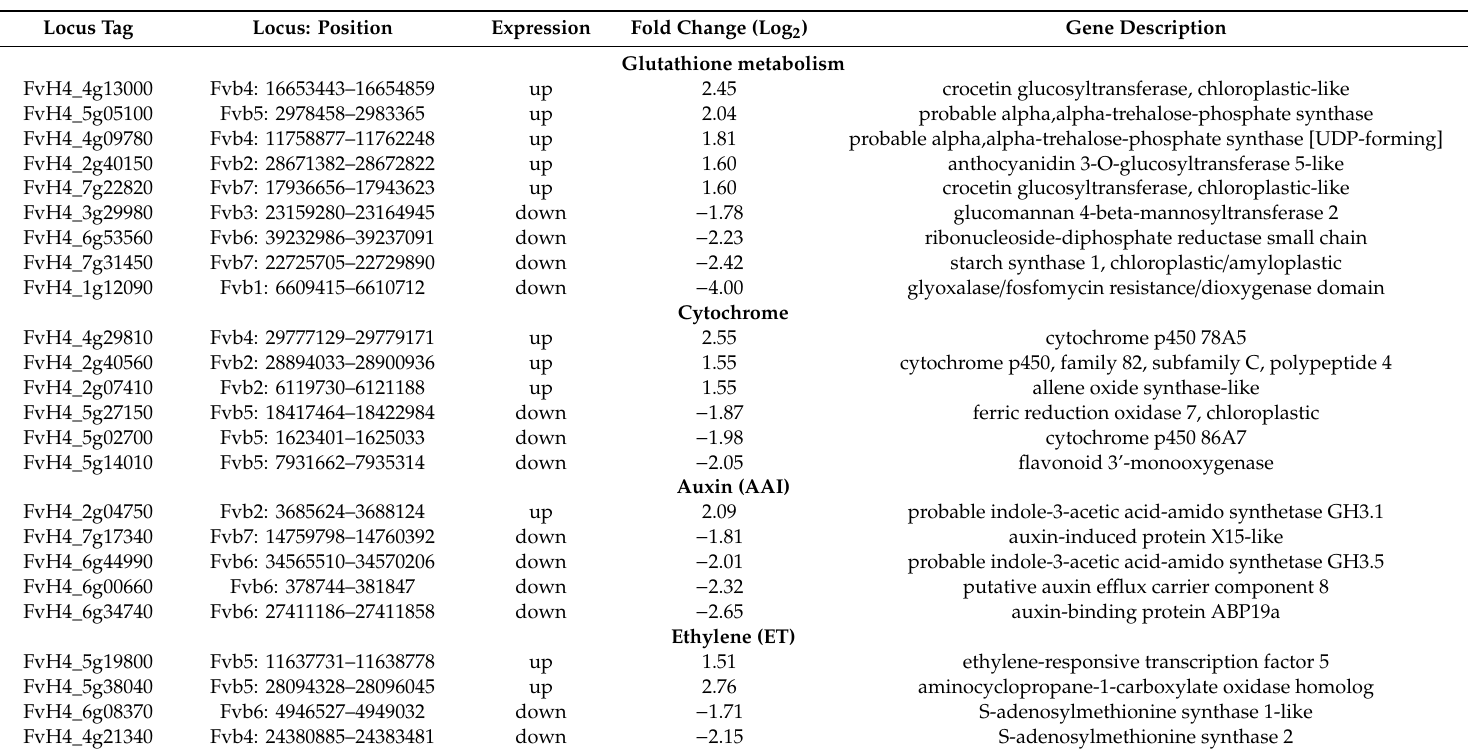
Table 3. Summary table of selected di ff erentially expressed Fragaria × ananassa genes challenged with Xanthomonas fragariae . A complete list of di ff erentially expressed genes is provided in Table